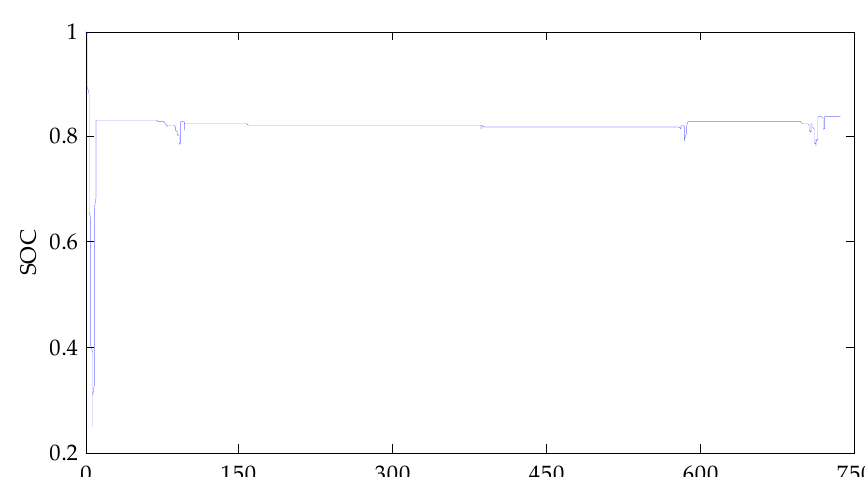
Figure 13. The charging and discharging current of SC.